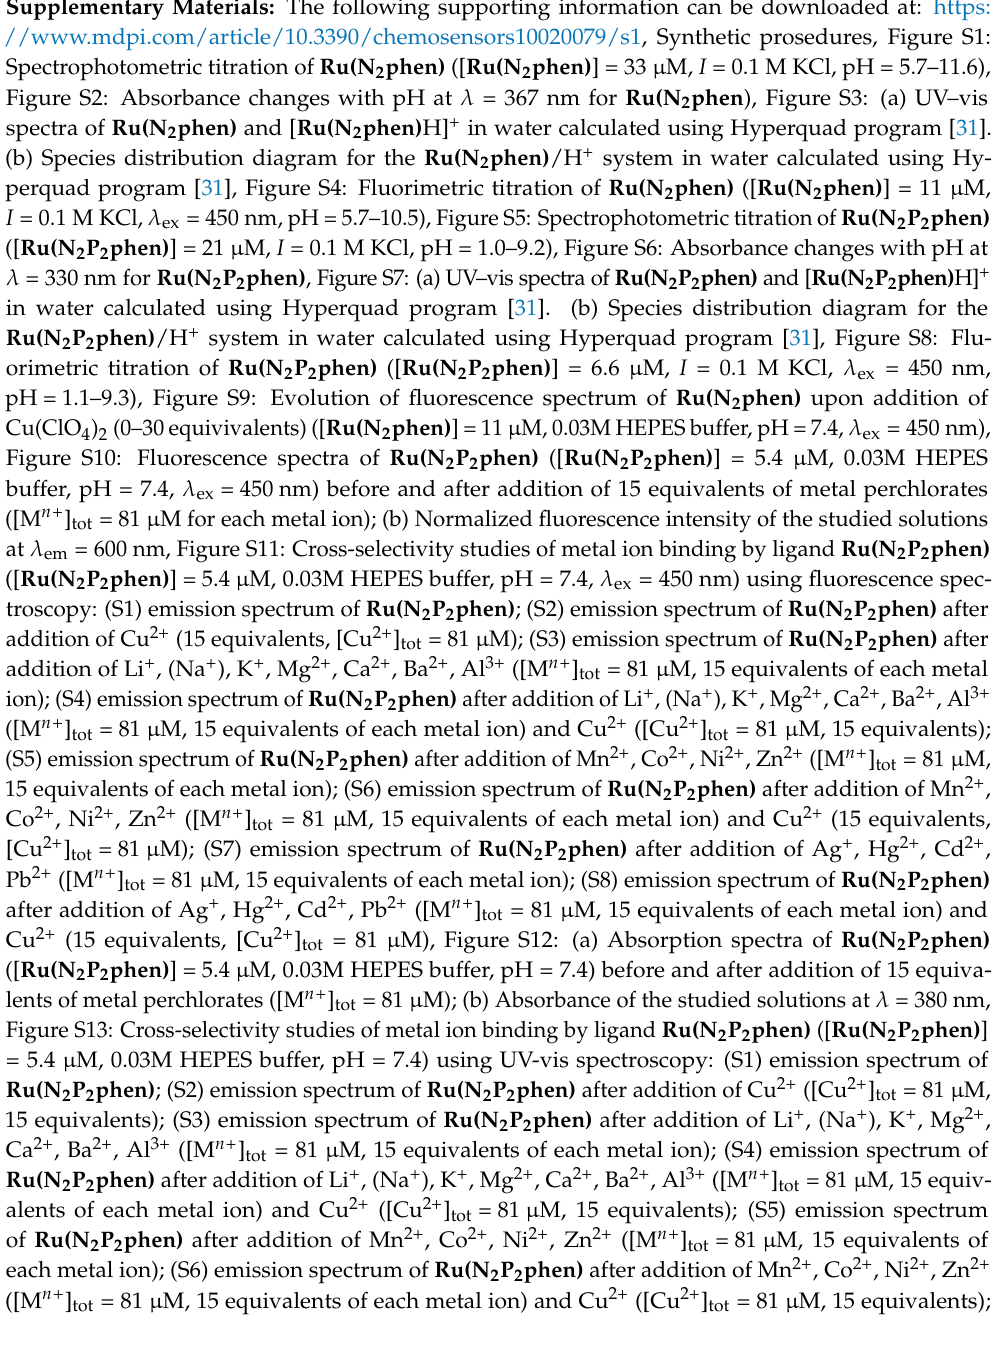
Figure S2: Absorbance changes with pH at λ = 367 nm for Ru(N 2 phen ), Figure S3: (a) UV–vis spectra of Ru(N 2 phen) and [ Ru(N 2 phen) H] + in water calculated using Hyperquad program [31].